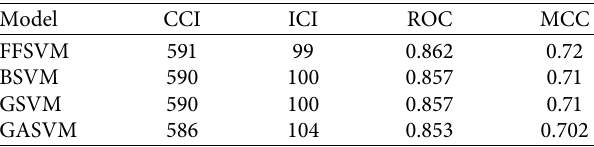
Table 6: Outcomes of the proposed algorithm and the three other algorithms (BSVM, GSVM, and GASVM) based on various pa- rameters such as CCI, ROC, MCC, and instance classification.